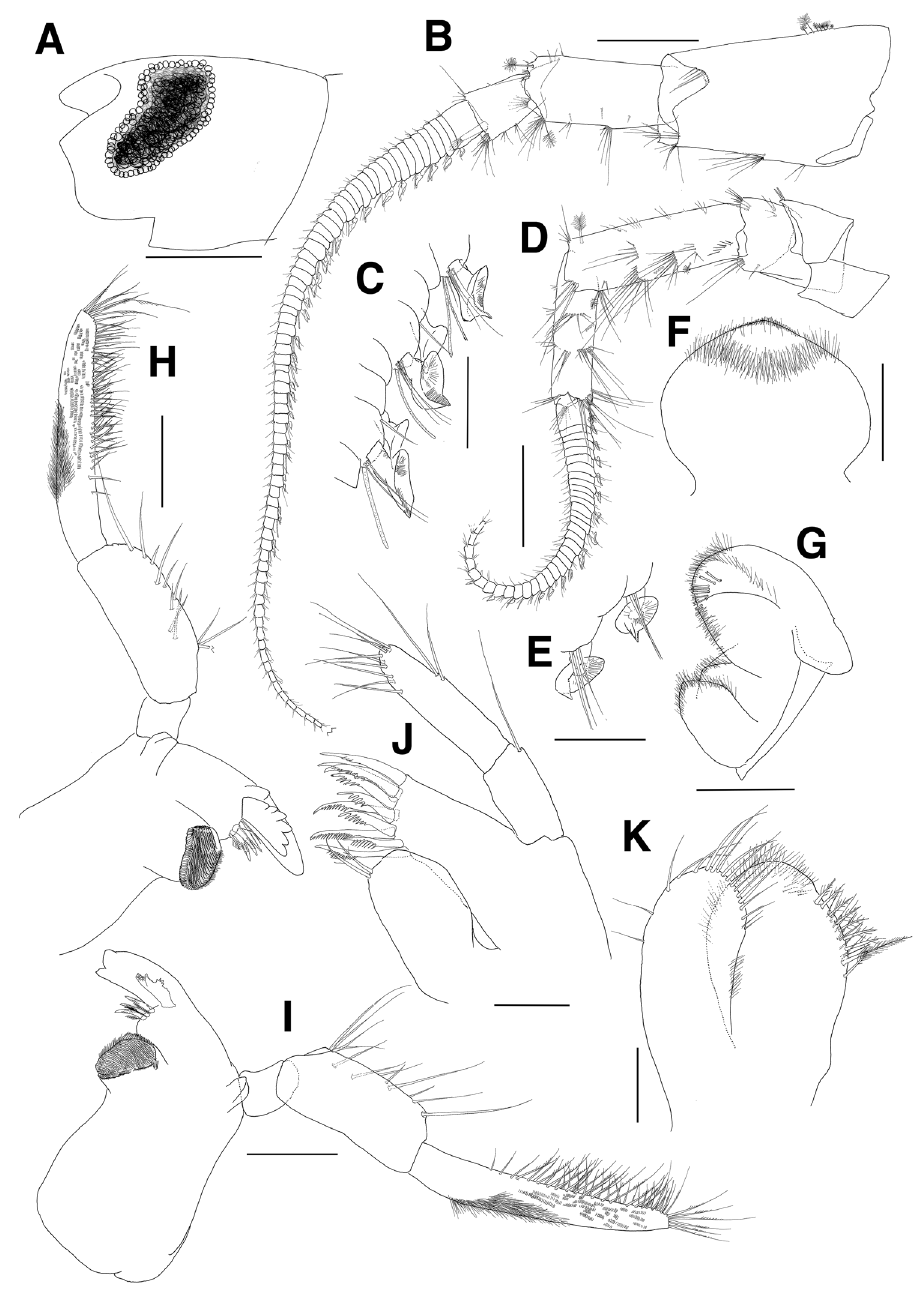
Figure 1. Eusiroides pilopalpus sp. n., holotype. A Head B Antenna 1 C Calceoli of flagellum on antenna 1 D Antenna 2 E Calceoli of flagellum on antenna 2 F Upper lip G Lower lip H Left mandible I Right mandible J Maxilla 1 K Maxilla 2. Scale bars 0.1 mm ( C, E, J, K ), 0.2 mm ( F–I ), 0.5 mm ( A, B, D